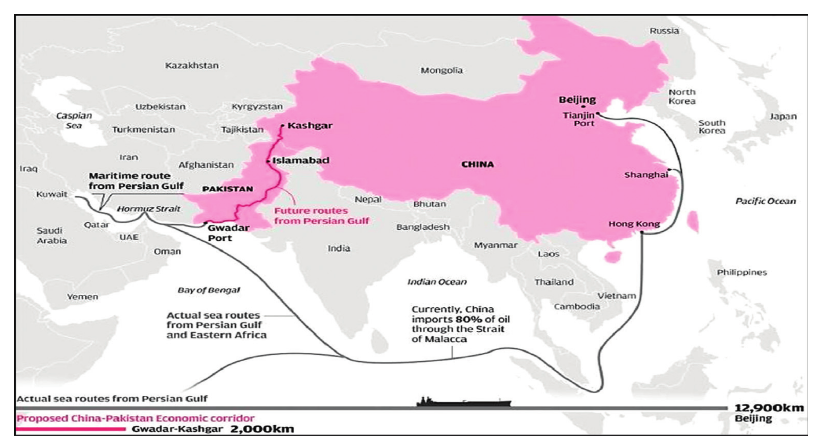
Figure 12: China alternative energy route